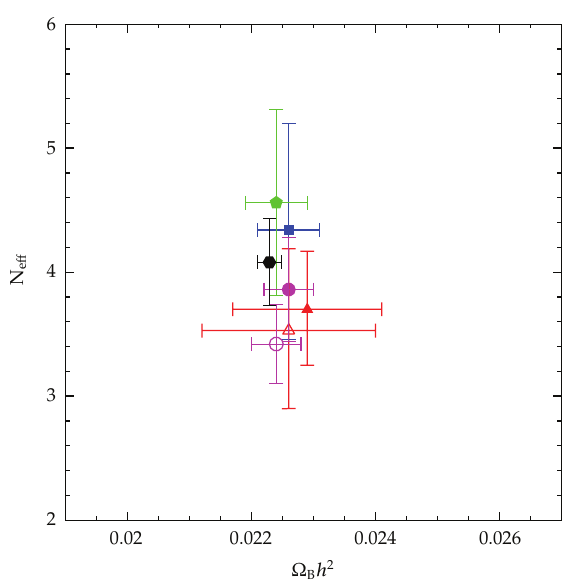
Figure 7: Comparing the BBN predictions of N e ff and Ω B h 2 with those from various CMB determinations: BBN D (cid:9) 4 He (cid:3) red-filled triangle (cid:4) , BBN D (cid:9) WMAP7 (cid:5) 38 (cid:6) Ω B h 2 (cid:3) red open triangle (cid:4) , WMAP7 (cid:5) 38 (cid:6) (cid:3) blue filled square (cid:4) , ACT (cid:5) 39 (cid:6) (cid:3) green-filled pentagon (cid:4) , SPT (cid:5) 40 (cid:6) (cid:3) purple filled circle (cid:4) , SPT (cid:9) Clusters (cid:5) 40 (cid:6) (cid:3) purple open circle (cid:4) , and WMAP7 (cid:9) ACBAR (cid:9) ACT (cid:9) SPT (cid:5) 41 (cid:6) (cid:3) black-filled hexagon (cid:4)